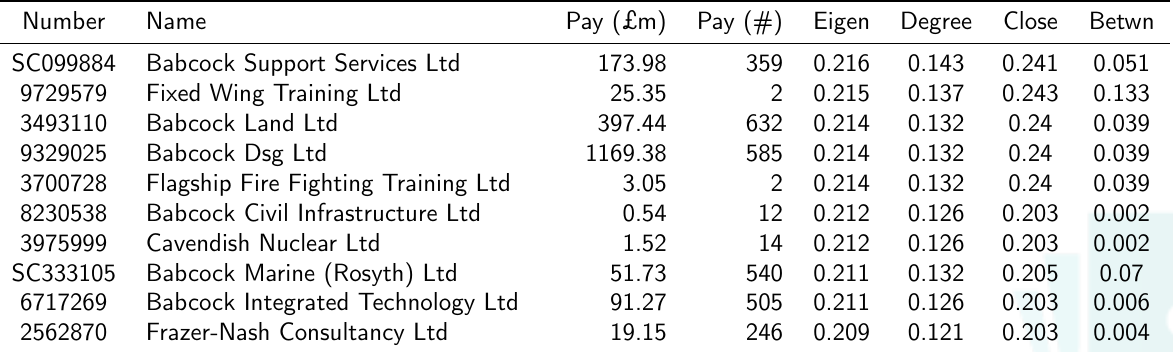
Table 1: Centrality in the Giant Component